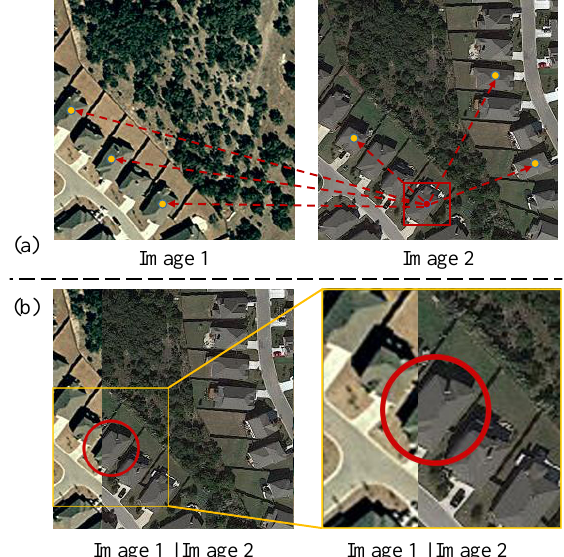
Figure 1. ( a ) Illustrations of spatial–temporal attention. The red lines denote selected spatial–temporal attention. ( b ) Illustrations of misregistration errors. (Zoom in for a better